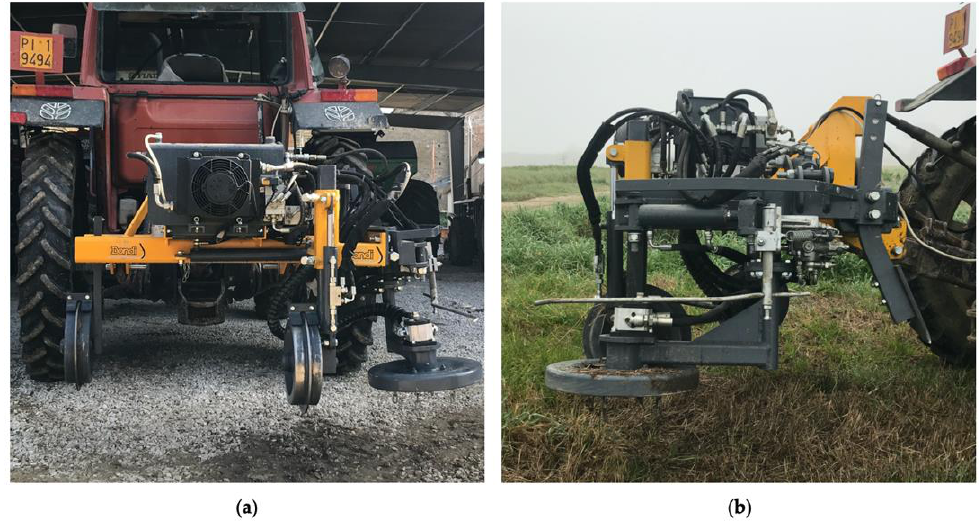
Figure 1. Rear ( a ) and lateral ( b ) view of the under-row mower.